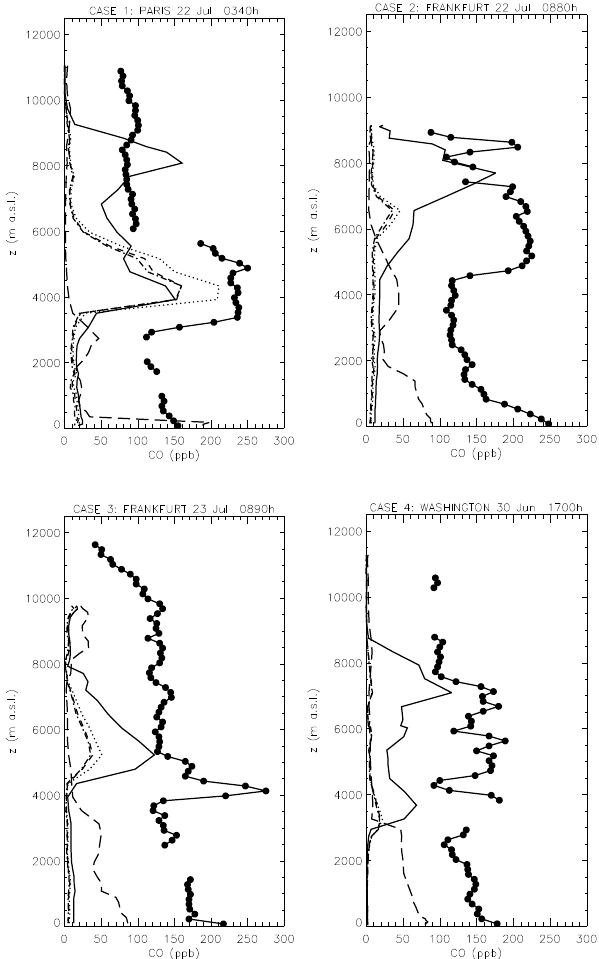
Fig. 10. Vertical profiles of MOZAIC CO for four case studies. The lines with filled circles represent MOZAIC data. The solid line represents CO from the FLEXPART simulation using an injection height of 10km, while the dotted, dashed and dash-dot lines corresponds to FLEXPART simulations using injection heights from the surface up to 3km, 1km, and 150m, respectively. The long dashed line represents CO produced from regional anthropogenic emissions.